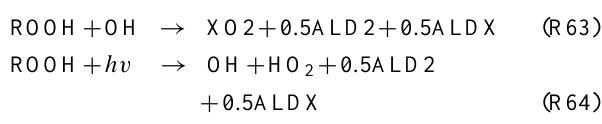
Table 4. Description of box model sensitivity